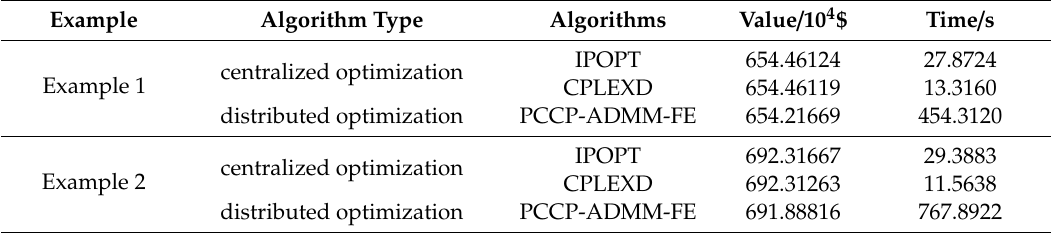
Table 1. Results comparison of centralized optimization and alternating direction method of multipliers (ADMM)-FE (forced equality)